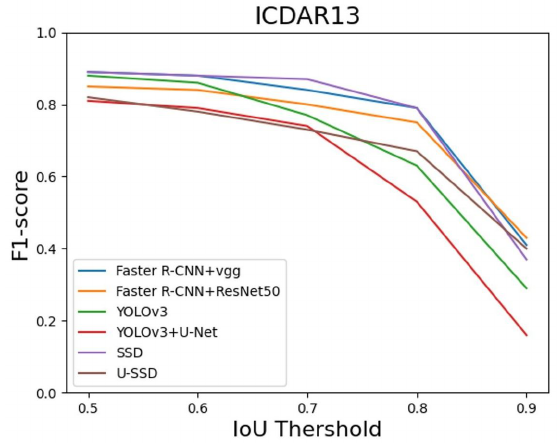
Figure 12. The F1-score from IoU = 0.5 to IoU = 0.9 on ICDAR13. Table 5. The F1-scores from IoU = 0.5 to 0.9 on open dataset.